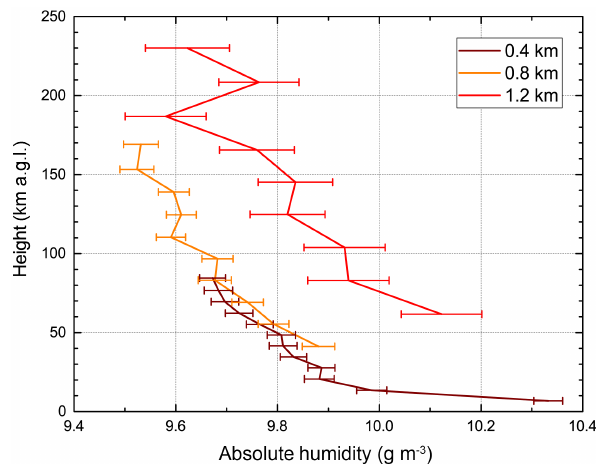
Figure 13. Absolute humidity profiles for the RHI scan of Fig. 12 for the horizontal distances of 0.4, 0.8, and 1.2km. The noise er- rors are also shown. The location of the WV and noise profiles are indicated by the dotted white lines in Fig.